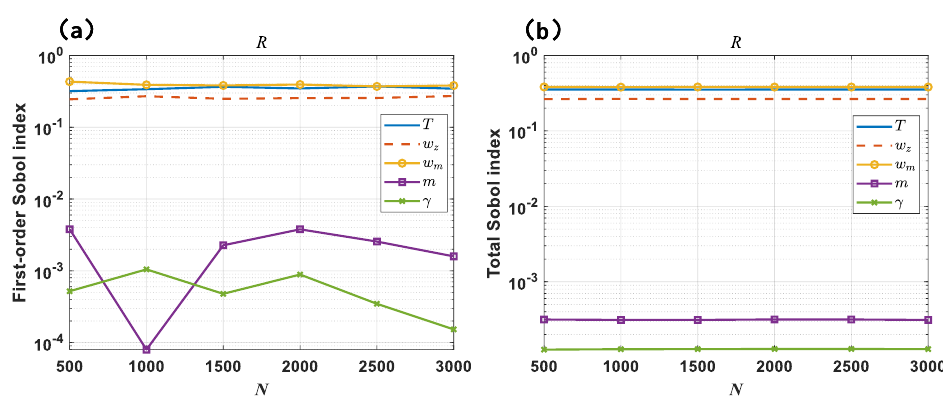
Figure 6. ( a ) Five atmospheric parameters’ first-order Sobol index convergence lines for the infra- sound propagation distance R ; ( b ) Five atmospheric parameters’ total Sobol index convergence lines for the infrasound propagation distance R (the blue, dark red, yellow, purple, and light green curves indicate temperature T , zonal wind w z , meridional wind w m , mean atmospheric molar mass m , and specific heat ratio γ , respectively).